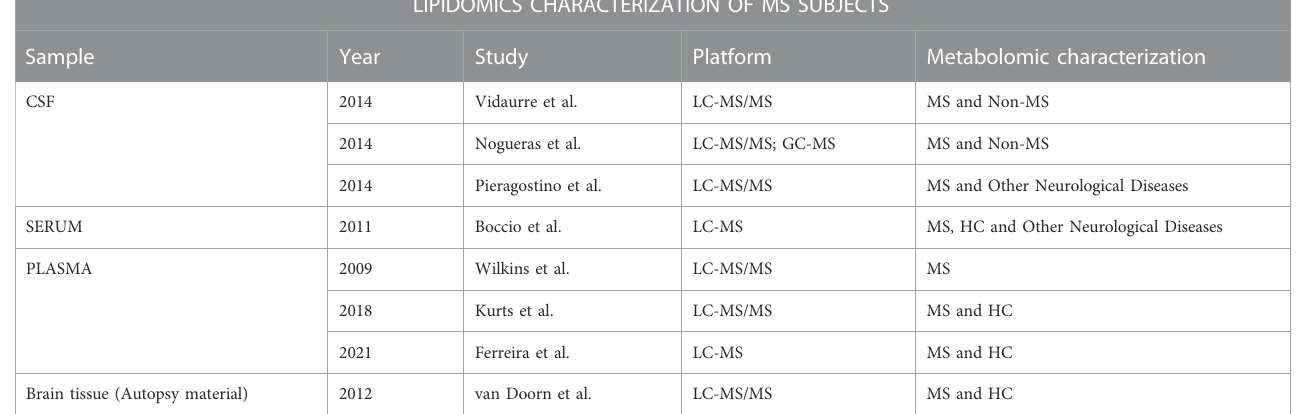
TABLE 5 Summary of lipidomics studies performed on MS patients LIPIDOMICS CHARACTERIZATION OF MS